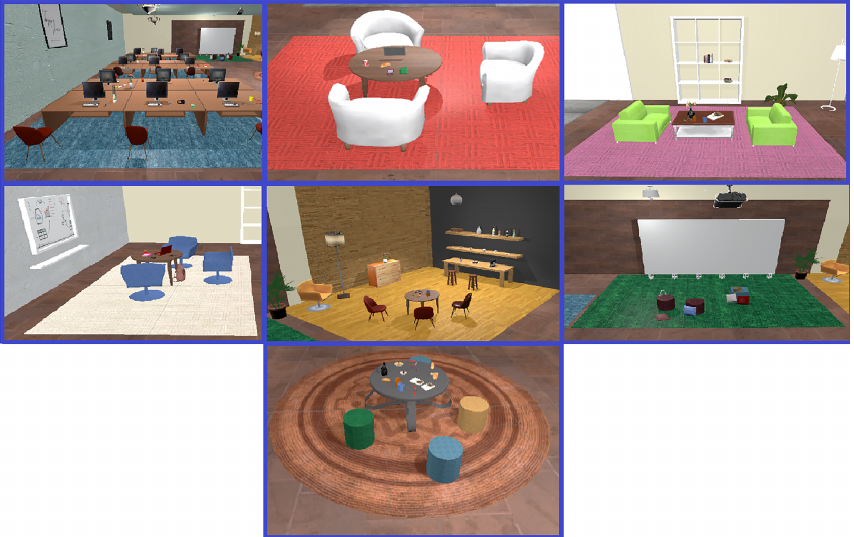
Figure 7. Screenshots from seven different areas for the placements of objects characterized by the color of their associated